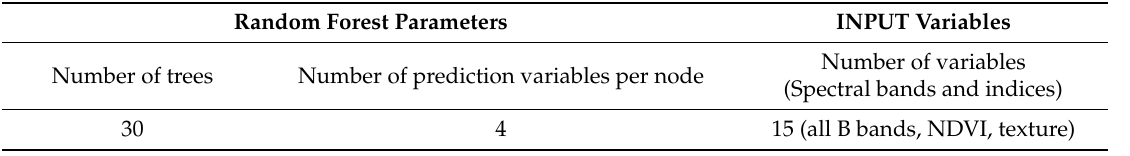
Table 5. Summary of parameters and inputs for Random